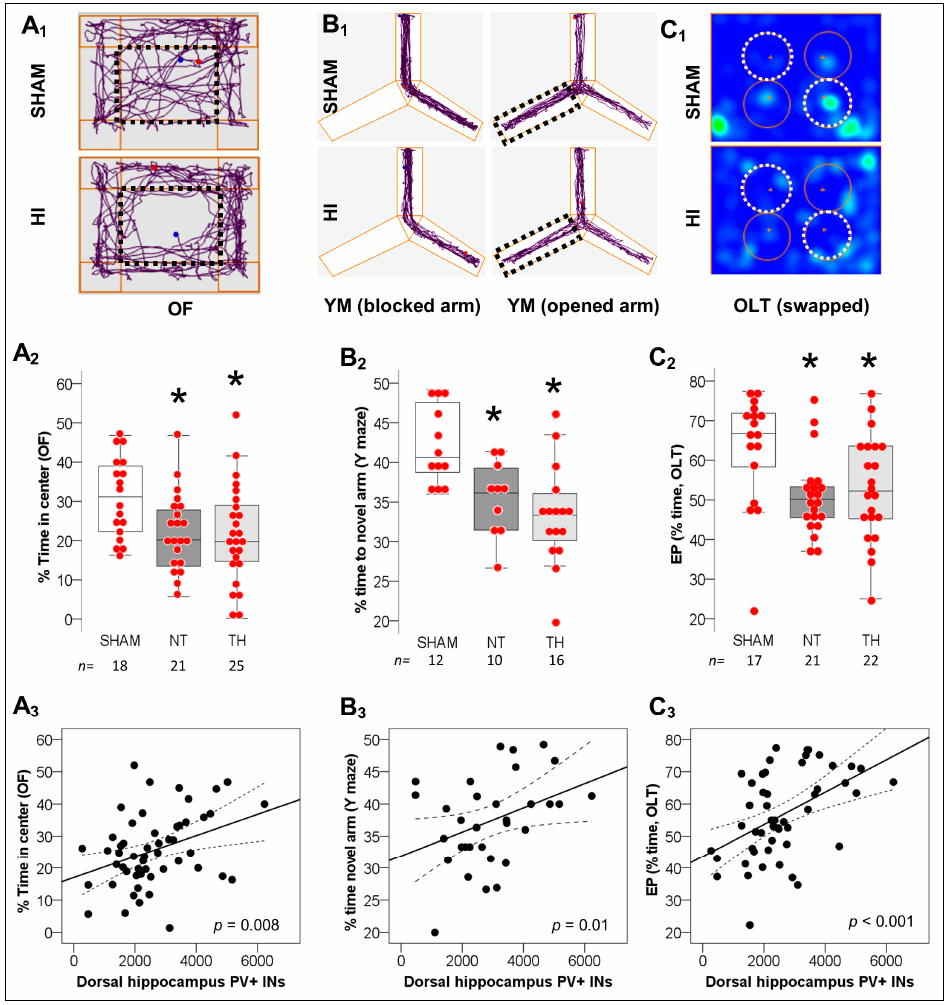
Figure 2. Behavioral Deficits after neonatal HI and correlation with deficits in hippocampal PV + INs. ( A ) HI-injured mice spent less time in the center of the open field (OF) arena (discontinued line rectangle) compared to sham mice. ( B ) Similarly, HI-injured mice explores the novel arm (previously blocked, discontinued line rectangle) for longer % time after being opened in the Y-maze phase 2 (YM). ( C ) Following the swap of objects (discontinued line circles) during the object location task (OLT) phase 2, the exploratory preference (EP) for non-familiar location is decreased in HI-injured mice. Representative Anymaze Software tracings for OF ( A 1 ) and YM ( B 1 ) along with heatmap for OLT (more time = brighter/ red, less time = darker/ blue) ( C 1 ) are shown. Quantifications for OF ( A 2 ), YM ( B 2 ), and OLT ( C 2 ) are shown as hybrid box and whiskers with dot plots. *, p < 0.05 (Dunn-Bonferroni post-hoc test for Kruskal Wallis- ANOVA). The number of PV + INs in the